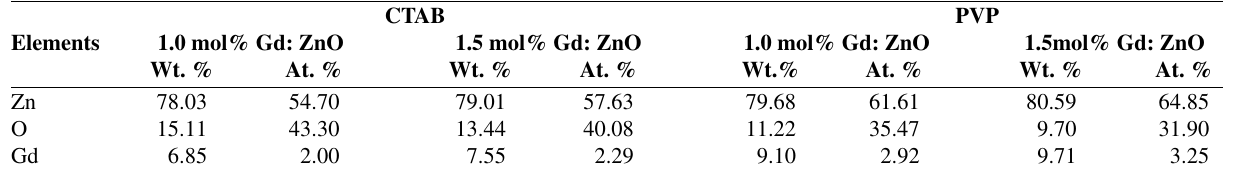
Table 3. Weight and Atomic percentage of Zn, O, and Gd in Gddoped ZnO NPs calculated from EDS spectra.